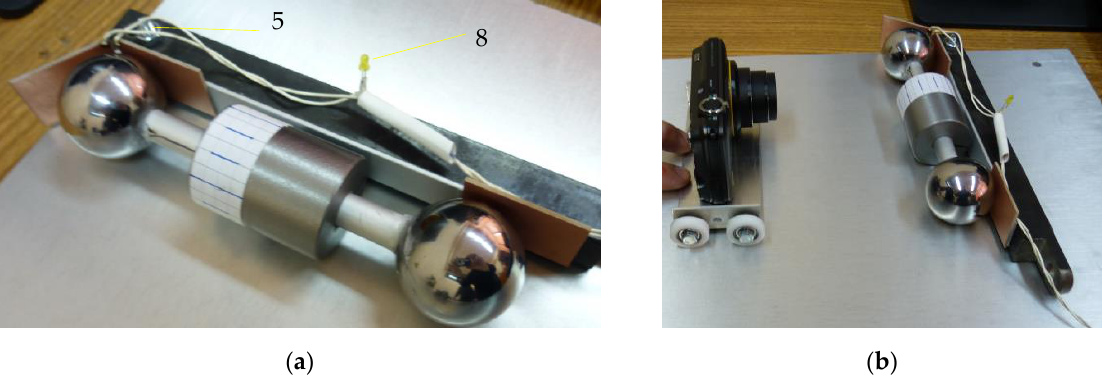
Figure 12. Details of the experimental set-up: ( a ) The rotor in initial launching position; ( b ) The launching instant (the LED is off) and the camera record the motion.